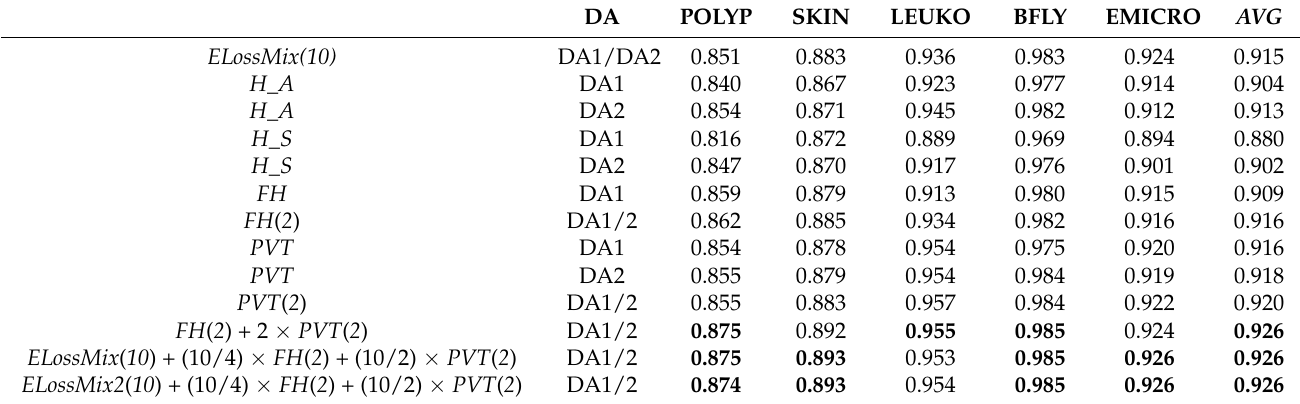
Table 4. Performance (dice) of some stand-alone methods and ensembles in the five benchmark datasets. Best performance is marked in bold